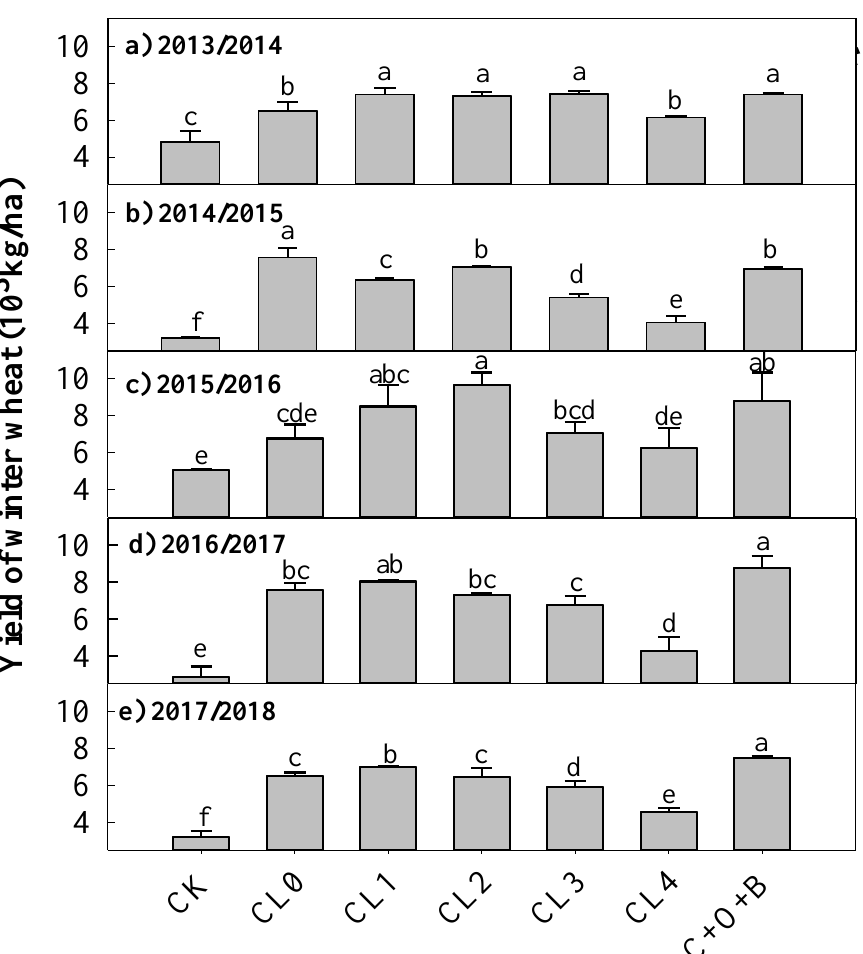
Figure 2. Grain yield of fertilization treatments (CK, CL0, CL1, CL2, CL3, CL4, and C+O+B) during the winter wheat production years 2013 – 2018 at the China North Plain. The grain yields in CL1 and C+O+B were 1.06 – 1.25 and 1.14 – 1.30 times more and that in CL4 were 0.57 – 0.95 times more as much as those in CL0 in the rest four growing seasons ( P < 0.001), respectively. The grain yields in CL2 and CL3 were 1.13 – 1.43 and 1.05 – 1.14 times more in the 2013/2014 and 2015/2016, and 0.96 – 1.00 and 0.90 – 0.91 times as much as that in CL0 in the 2016/2017